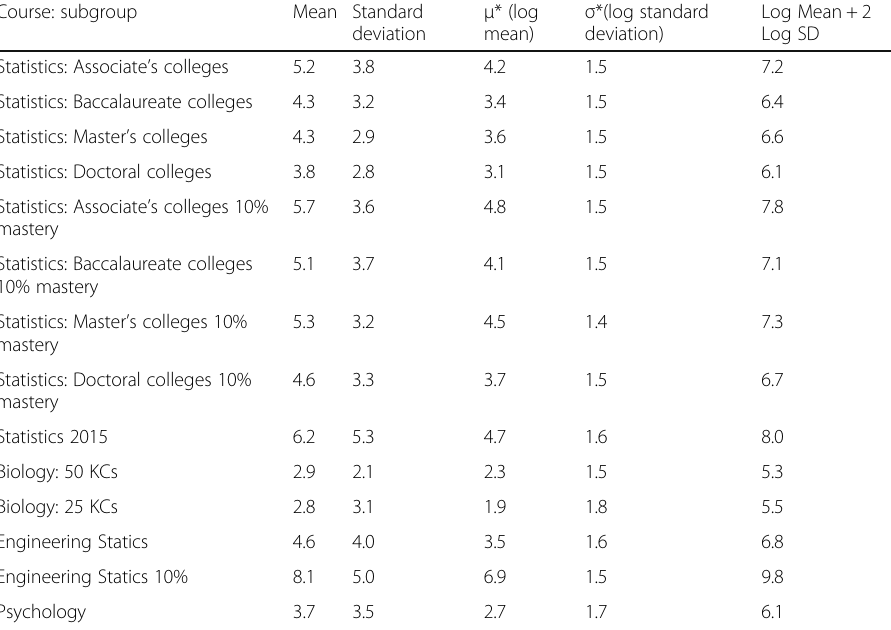
Table 12 Comparison between mean, standard deviation and log mean + 2SD for all subgroups Course: subgroup Mean Standard